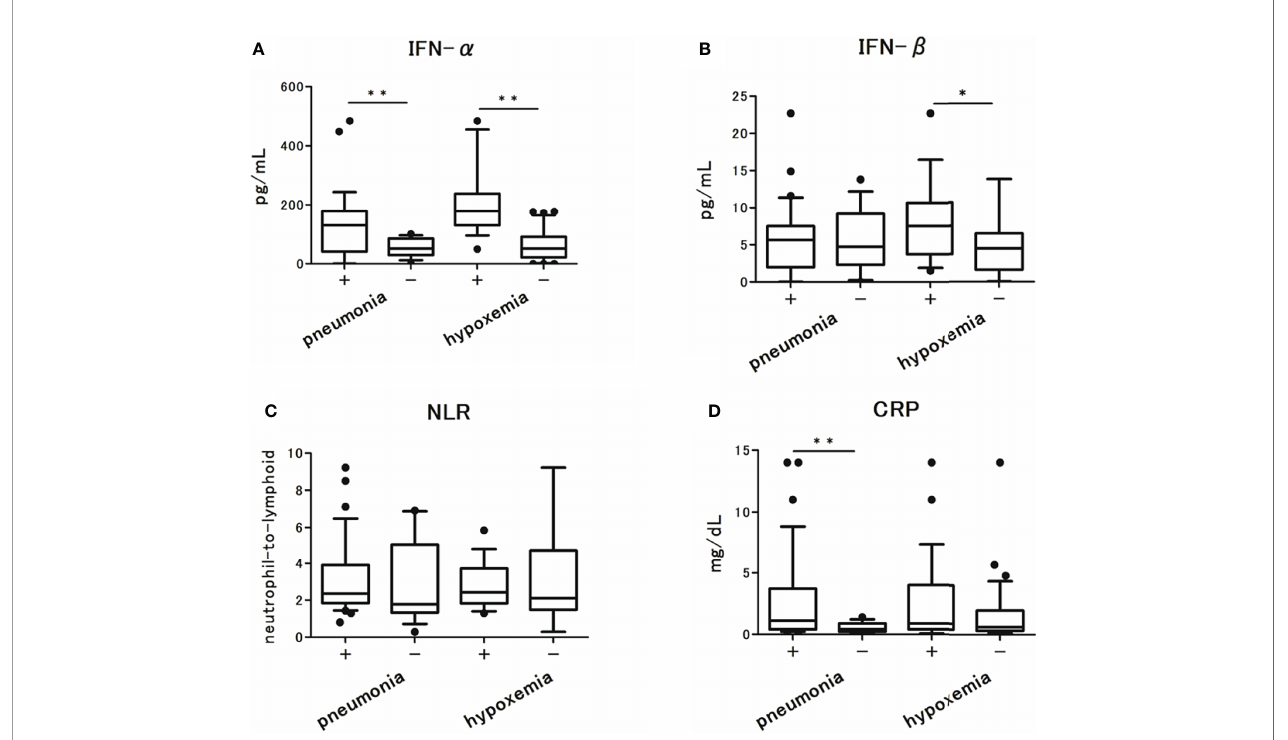
FIGURE 1 | The serum type I Interferon (IFN) levels in patients with COVID-19 and their association with pneumonia and hypoxemic respiratory failure: (A) IFN- a levels, (B) IFN- b levels. (C) CRP levels, and (D) Neutrophils-to-lymphocytes ratio in patients with COVID-19. Each level was measured at the time of admission (within 5 days after the onset of symptoms), without hypoxemic respiratory failure at the time. Data are presented as Tukey boxplots and individual values. Nonparametric Mann-Whitney test was used to compare values between groups: *p < 0.05. **p <